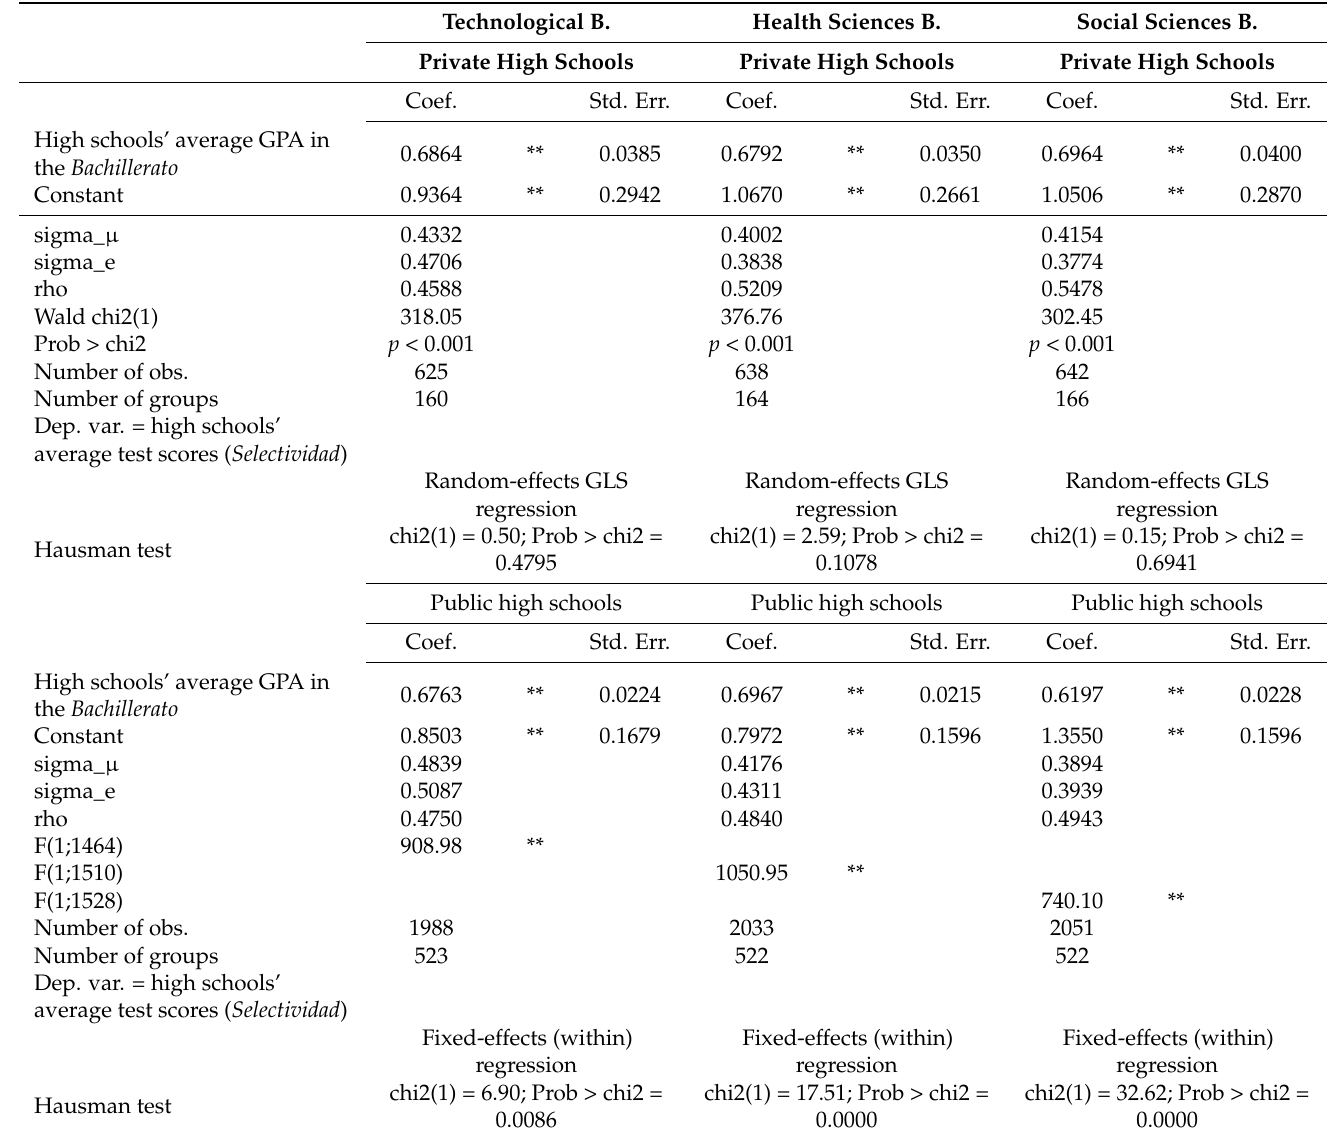
Table 2. Andalusian high schools’ results in university entrance examinations: panel data estimates. Technological